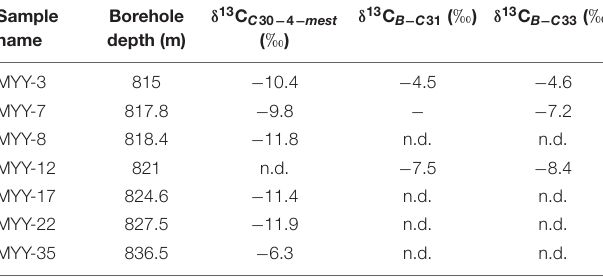
TABLE 3 | The δ 13 C of source-specific compounds of C 30 -4-methyl sterane, C 31 -Botryococcane, and C 33 -Botryococcane in some representative